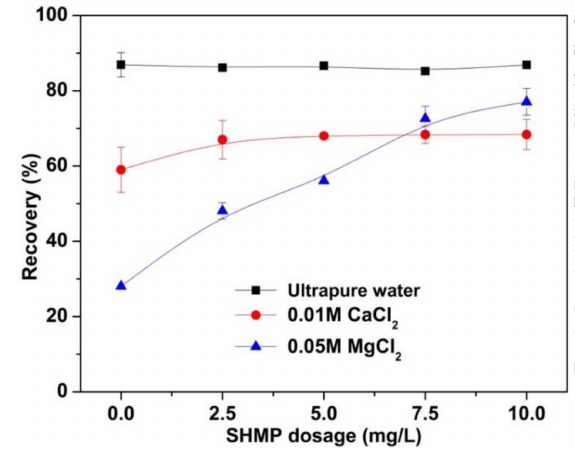
Figure 3. Effects of SHMP dosage on chalcopyrite recovery at pH 9.5.